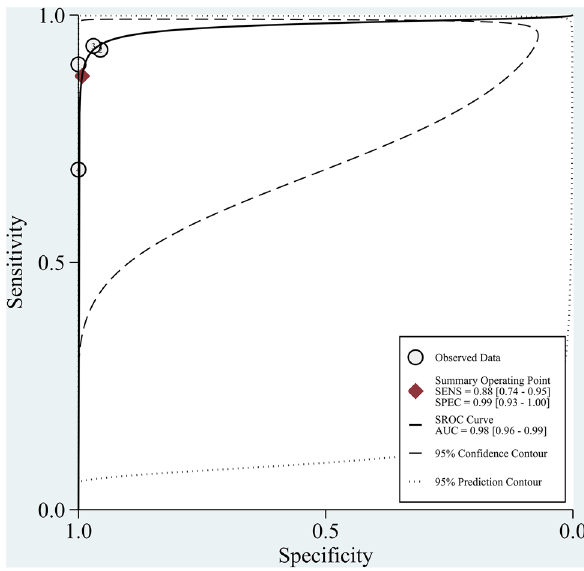
Figure 4. SROC curve for CBCT in scaphoid fracture detection.